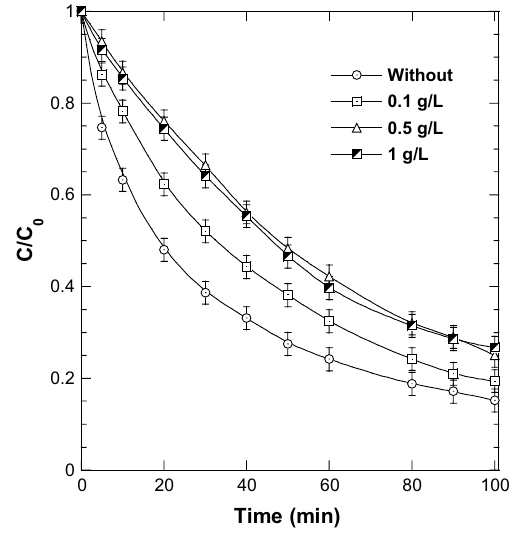
Fig. 10 Degradation kinetics of TB for various solution temperatures (conditions—volume: 100 mL, initial TB concentration: 2 mg/L, tem- perature: 25–50 °C, pH ~ 6, frequency: 1700 kHz, power: 15 W)